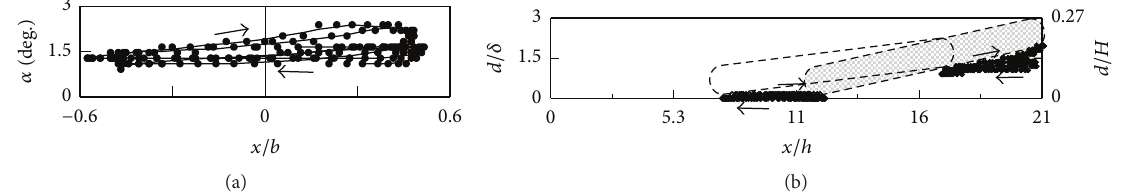
Figure 9: The change of the body angle (a) and the dimensionless gap (b) during the oscillations.